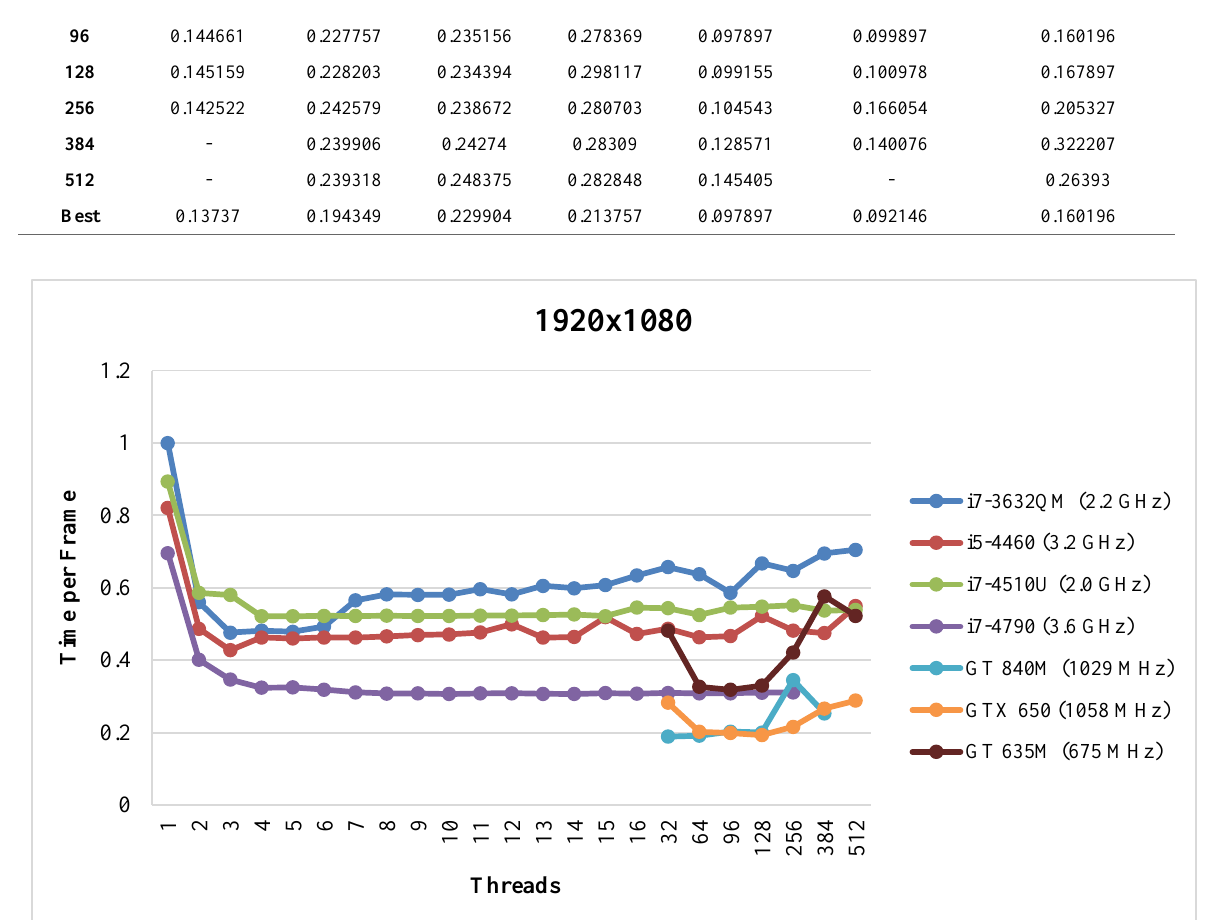
Figure 9. Compare the runtime of different threads for different CPU and GPU to generate an image in 1080p resolution